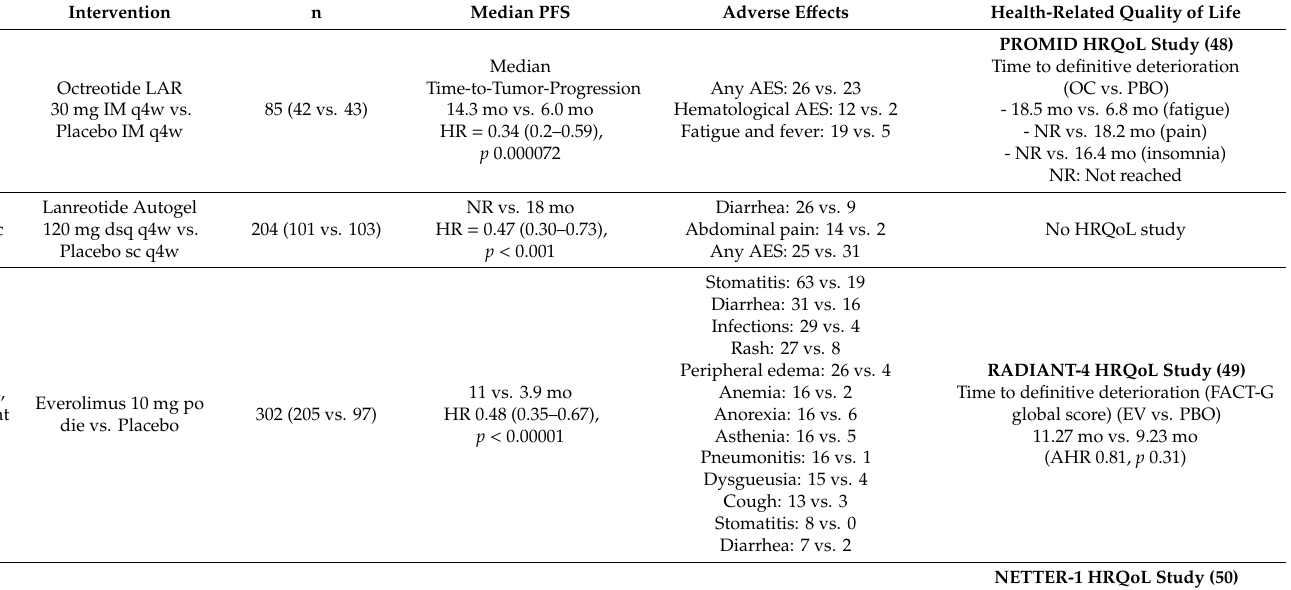
Table 2. Landmark trials in the treatment of advanced or metastatic neuroendocrine tumors